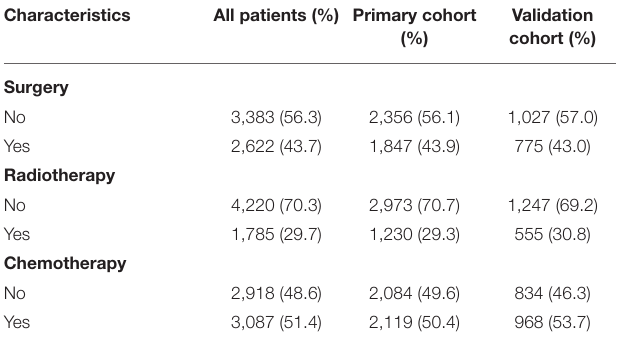
TABLE 2 | Characteristics with mRCC patients in primary and validation